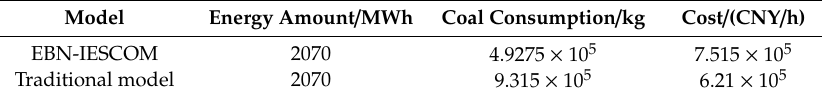
Table 13. Simulation results of energy consumption and cost